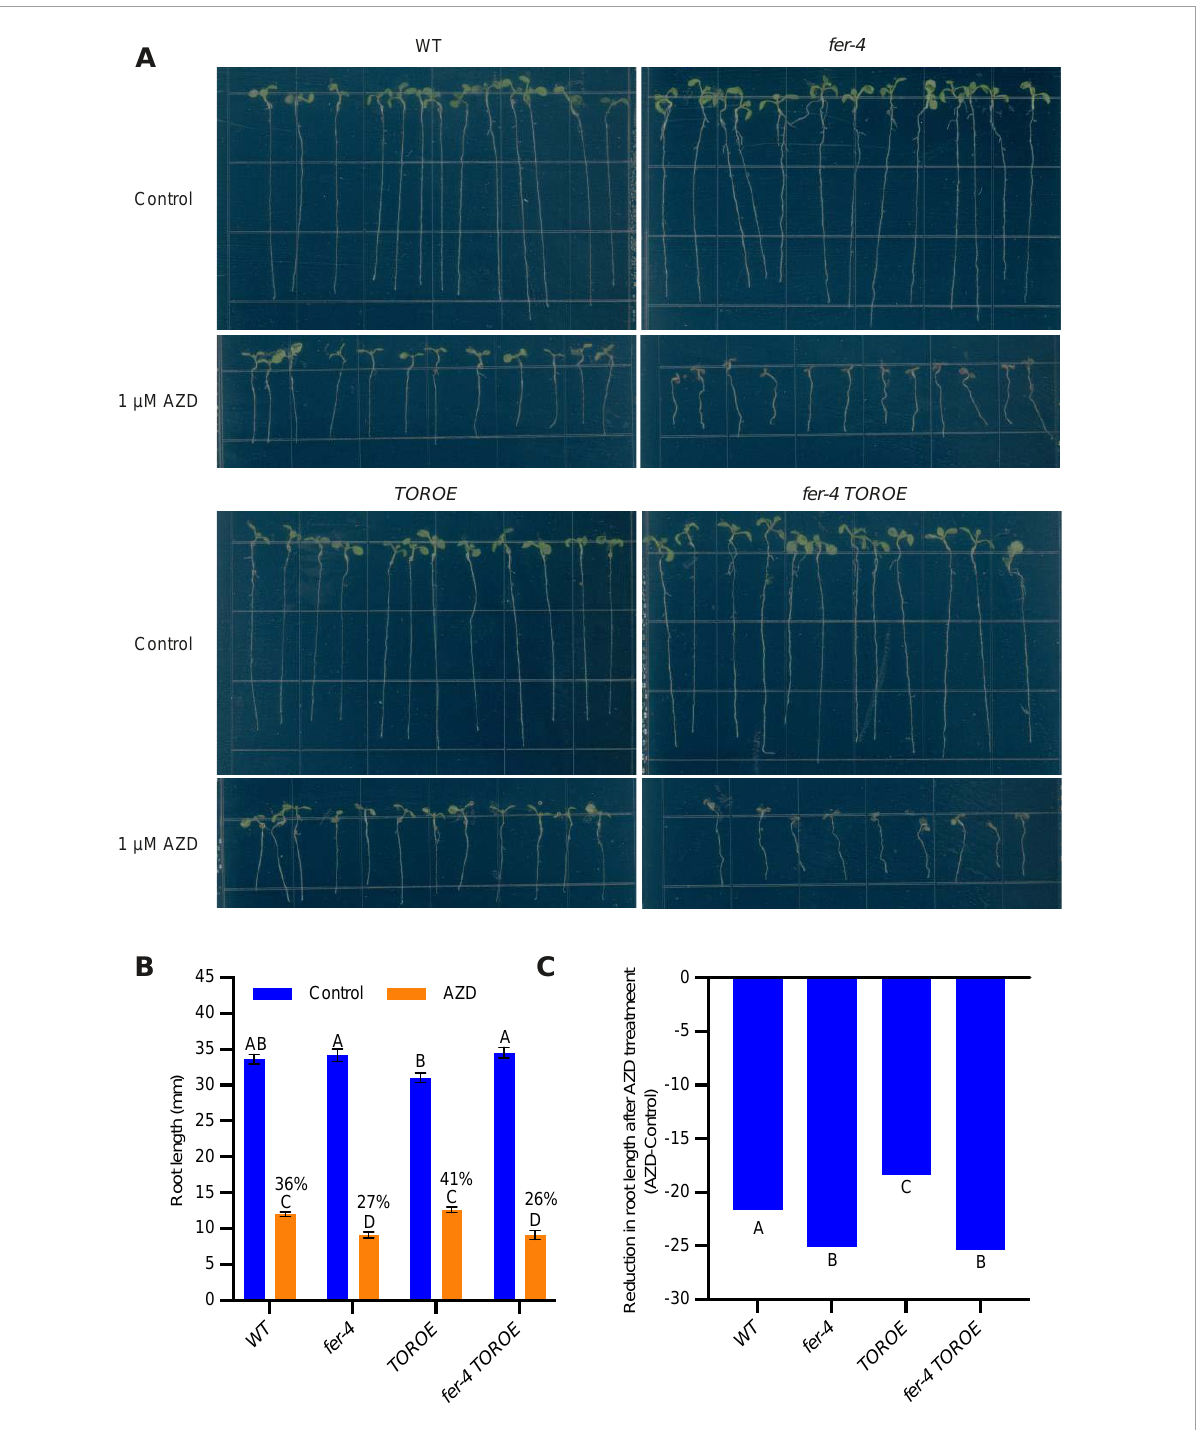
FIGURE6 fer-4 was more sensitive to AZD in root growth assay. (A) Images of 7-day-old seedlings of WT, fer-4 , TOROE and fer-4 TOROE grown on control 1/2 MS plates or plates containing 1 µ M AZD8055. (B) Root length measured from seedlings of A using ImageJ. Data are shown as means ± SEM ( n = 12). Different letters indicate significant difference among groups subjected to one-way ANOVA Tukey’s multiple range tests ( p < 0.05). (C) Root growth inhibition by AZD8055 was analyzed using a generalized linear model (glm package in R) with genotype and treatment (Control or AZD) as fixed factors. The genotypes were categorized as significantly differentially responsive to AZD if they had a genotype-by-treatment interaction p -value < 0.05 compared to all other genotypes ( n =